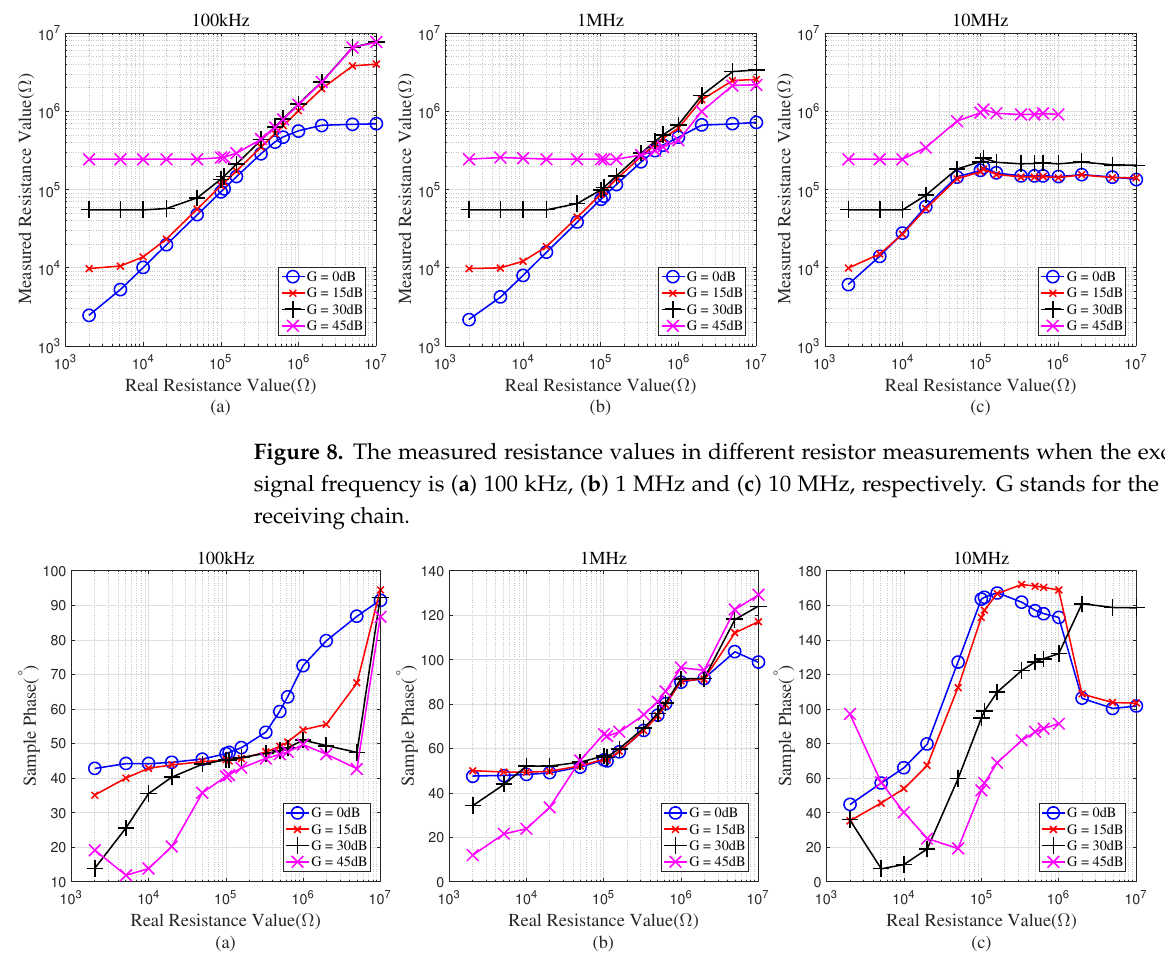
Figure 9. The sample phases in different resistor measurements when the excitation signal frequency is ( a ) 100 kHz, ( b ) 1 MHz and ( c ) 10 MHz, respectively. G stands for the gain of receiving